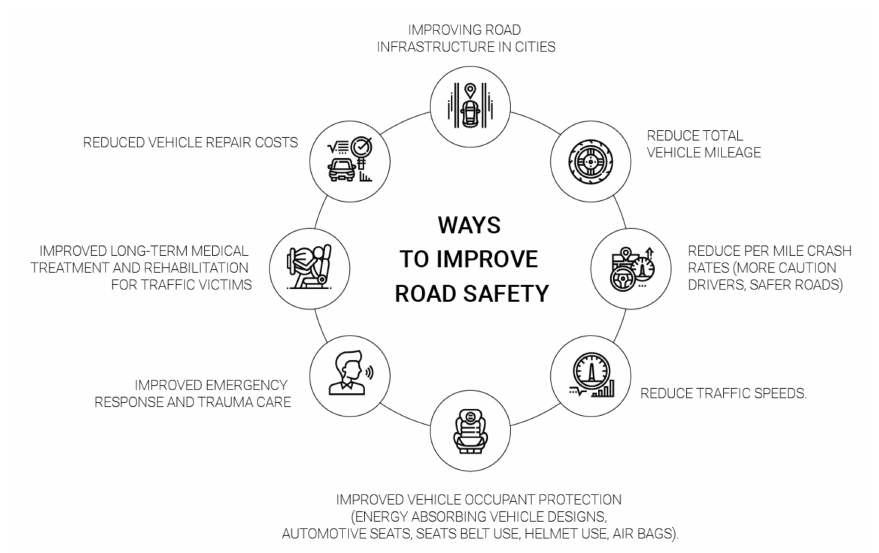
Figure 1. Examples of ways to improve road